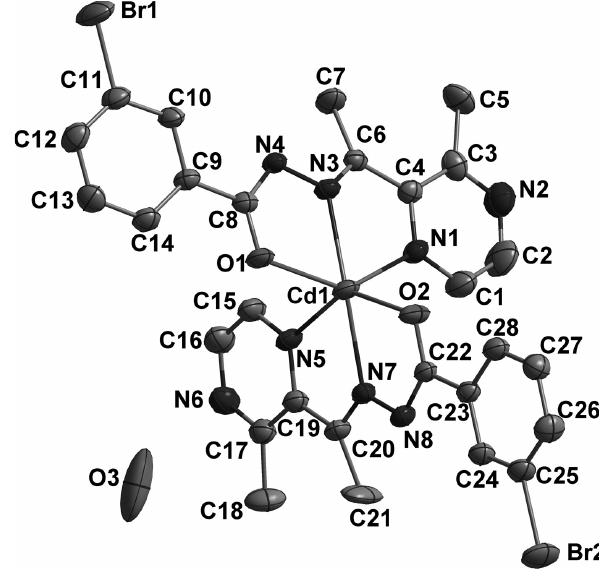
Table 1: Data collection and handling.